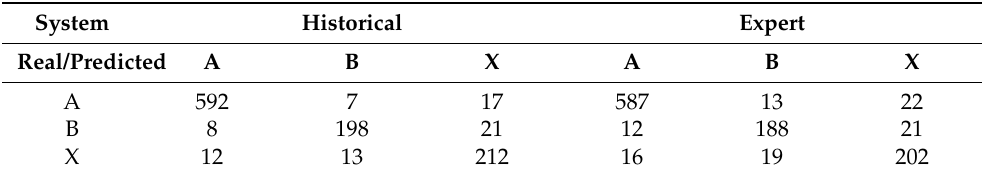
Figure 7. Modes of operation proposed by the recommendation system ( a ), historical modes of operation ( b ), and modes of operation recommended by expert knowledge ( c ) in the heap leaching phase. Table 4. Confusion matrix between system recommendations versus historical operating modes and domain expert